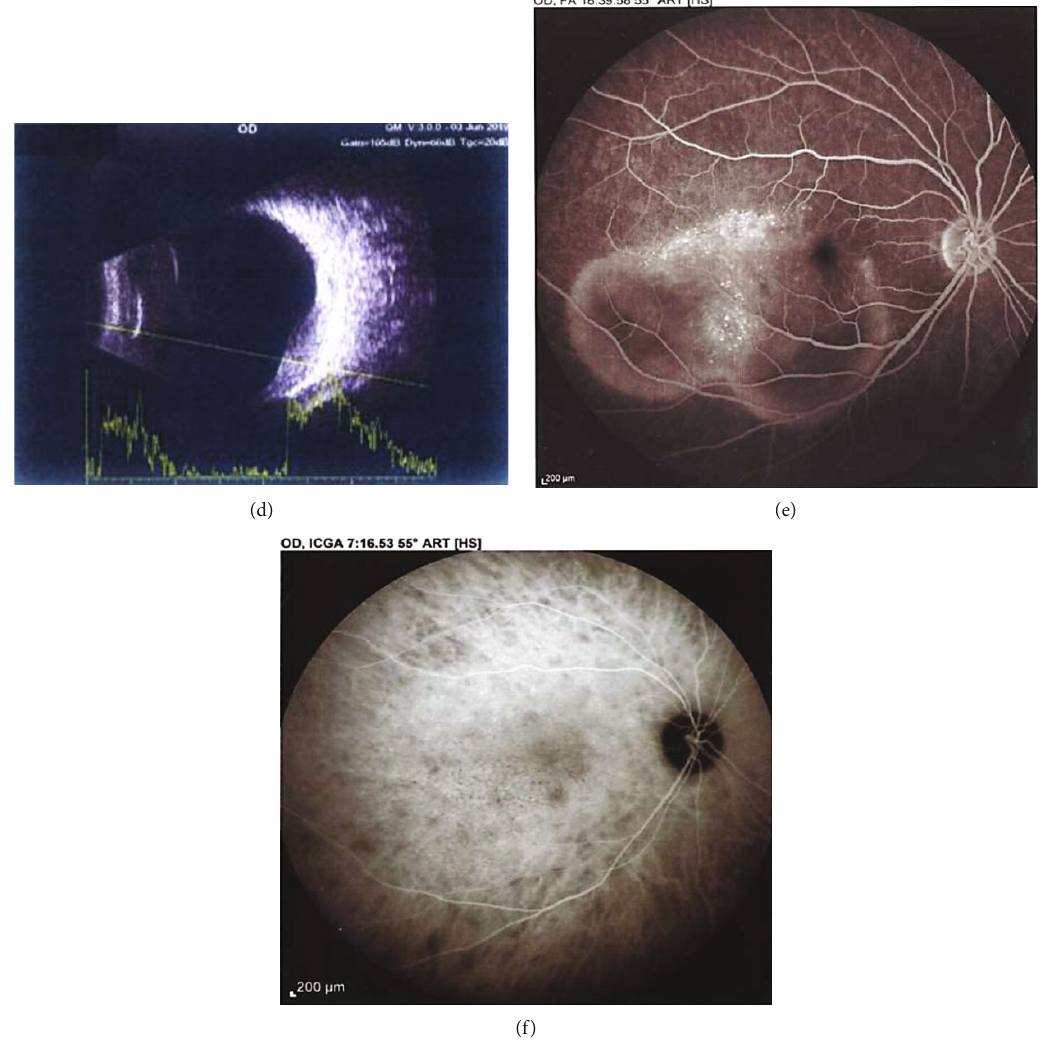
Figure 1: Initial examination of the right eye. Color fundus photo shows subretinal fl uid (arrows) and elevated subretinal mass extending beyond the inferior arcade (a). Horizontal scans of optical coherence tomography (OCT) from the fovea to inferior vascular arcade shows subretinal fl uid with a dome-shaped elevated choroidal mass in the macular area (b). Vertical scan of enhanced depth imaging optical coherence tomography shows a homogenous hypore fl ective elevated lesion in the choroid (c). Ultrasonography shows a hyperechoic choroidal mass with medium to low internal re fl ectivity (d). Fluorescein angiography in the late phase shows the pooling of dye in the subretinal area and multiple hyper fl uorescent dots over the lesion (e). Midphase indocyanine green angiography reveals multiple small, round, hypocyanescent dots in the posterior and midperipheral fundus